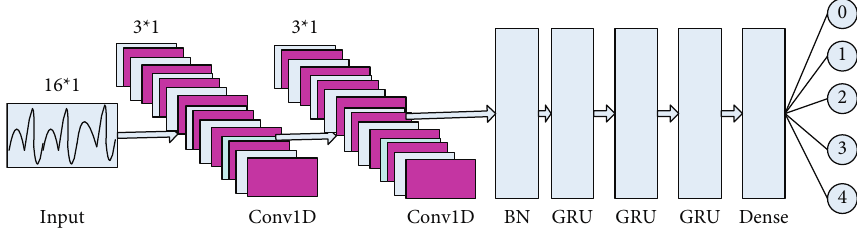
Figure 3: EEG emotion classification model Conv1D_ GRU.